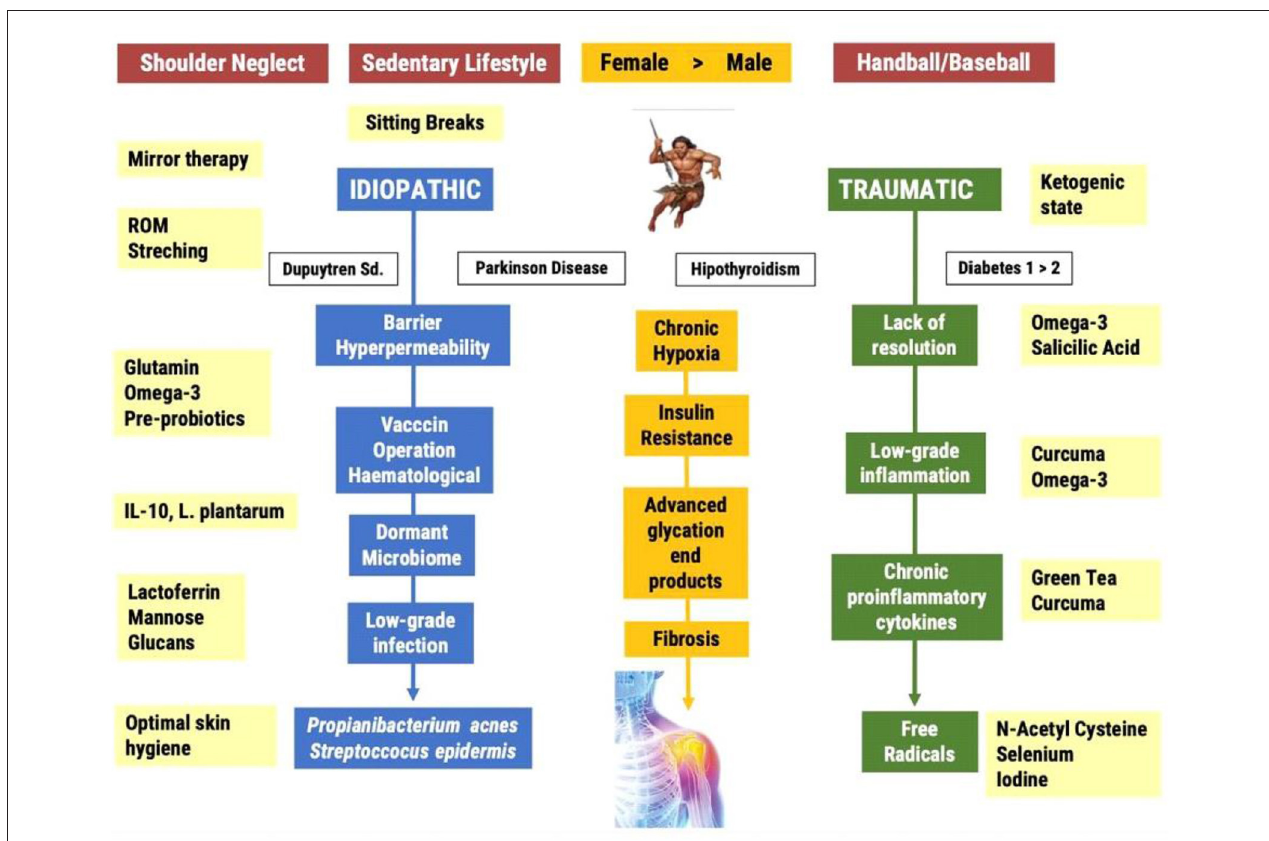
FIGURE 1 | Current and proposed pathways leading to the Frozen Shoulder Syndrome; from the photo to the